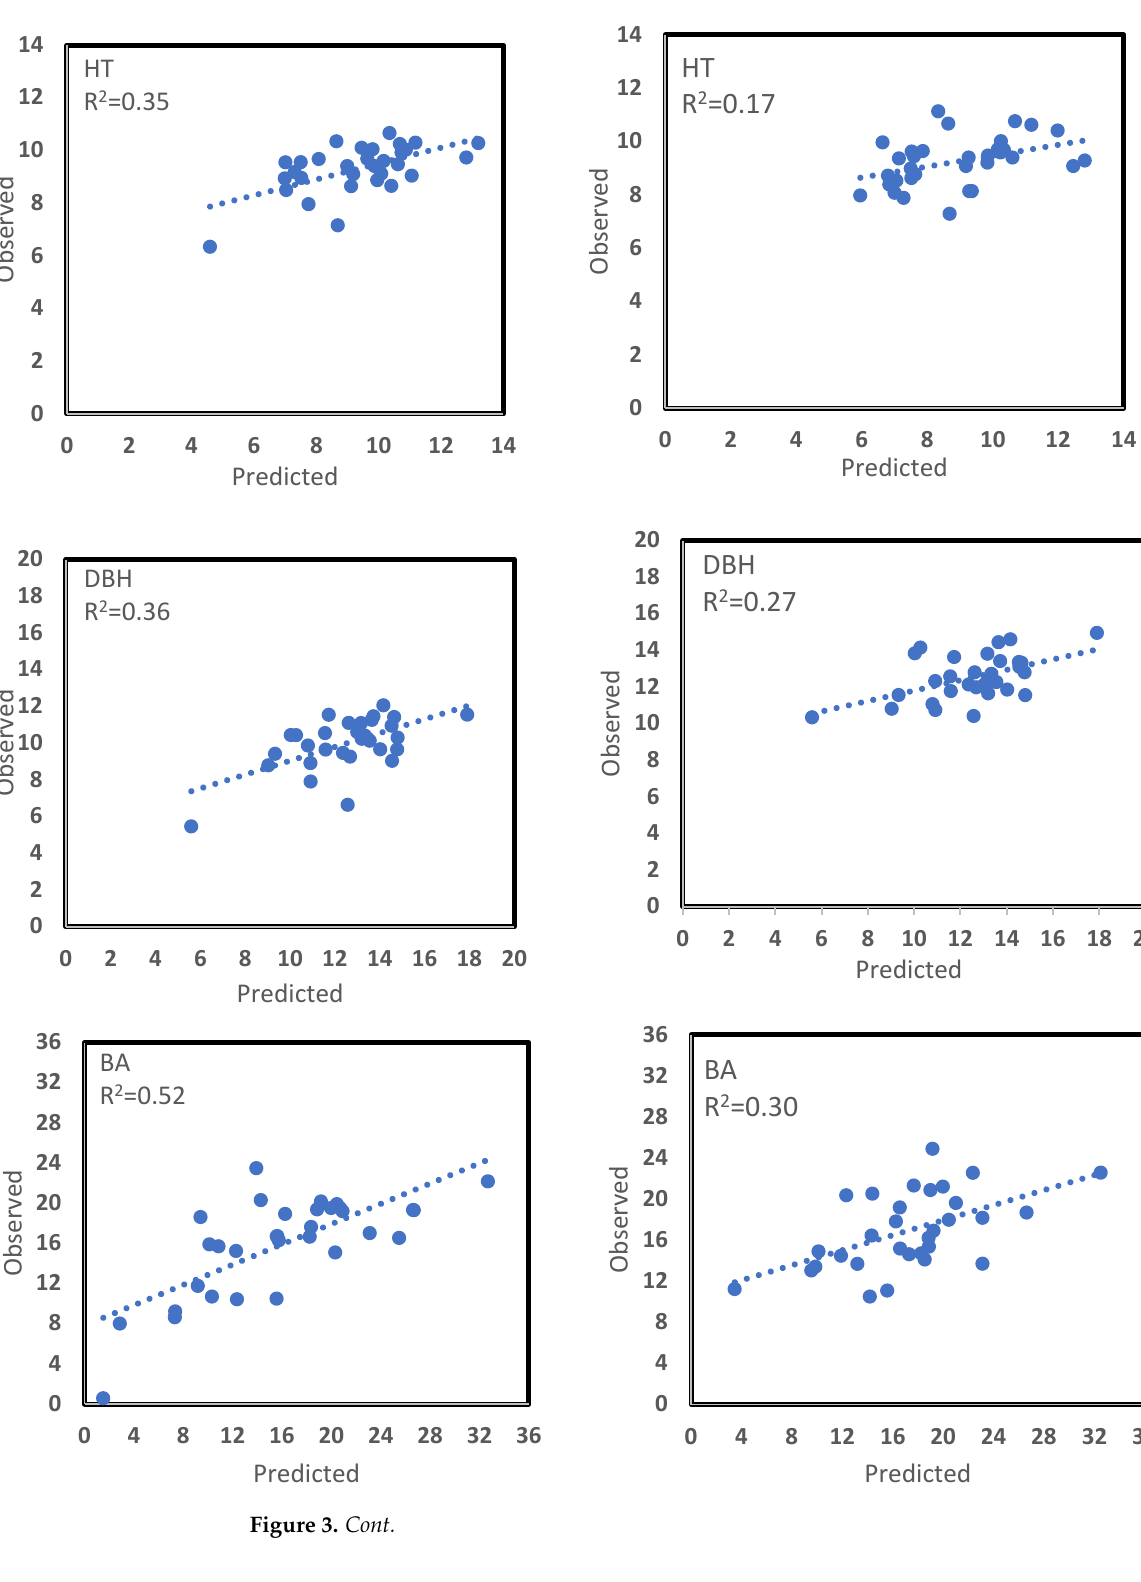
Figure 2. Relationships between observed and predicted values based on the independent test da ‐ taset of the 1st cycle measurement: multiple linear regression models on left column and random forests models on the right column.